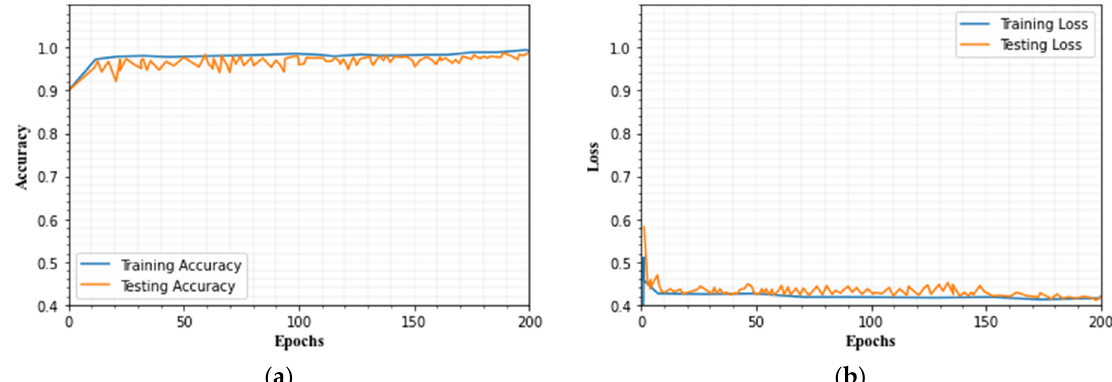
Figure 15. Analysis of data imbalance technique.